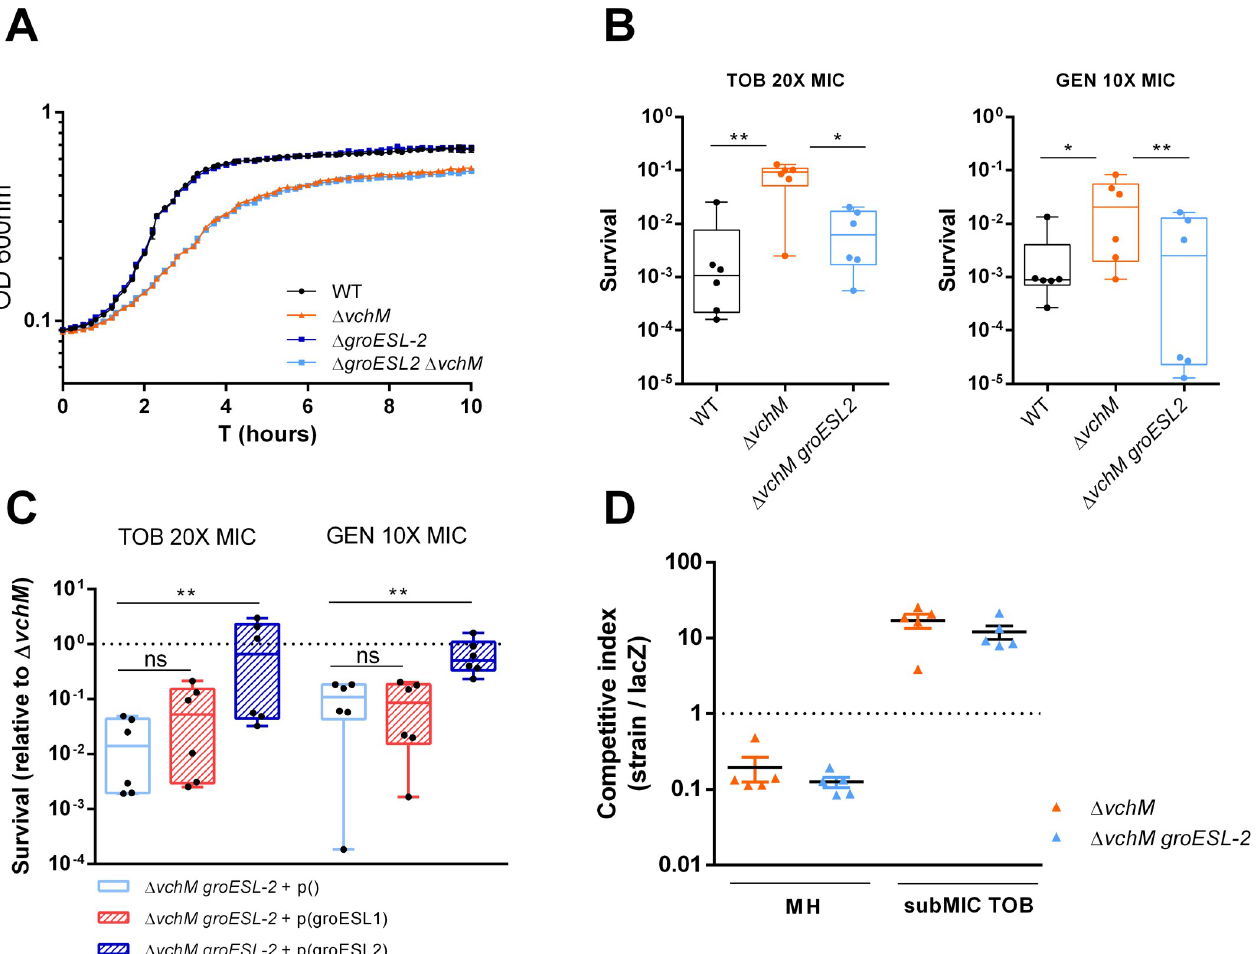
Fig 4. groESL-2 is needed for the increased tolerance of Δ vchM to lethal AG treatment. A. Growth curves in MH medium. Means and SD are represented, n = 3. B. Survival of stationary-phase WT, Δ vchM and Δ vchM Δ groESL-2 cells exposed to lethal aminoglycoside treatment for 7 hours. Box plots indicate the median and the 25 th and 75 th percentiles; whiskers indicate the min and max values (n = 6 from two independent experiments). C. Survival (after 7 hours AG treatment) of Δ vchM groESL-2 double mutant harboring an empty plasmid or a plasmid expressing either groESL-1 or groESL-2 , relative to survival of the Δ vchM with the control plasmid. Box plots indicate the median and the 25 th and 75 th percentiles; whiskers indicate the min and max values (n = 6 from two independent experiments). In B and C statistically significant differences were determined using Friedman’s test with Dunn’s post-hoc test for multiple comparisons. � P < 0.05, �� P < 0.01, ns = not significant. D. In vitro competitions of Δ vchM and Δ vchM groESL-2 double mutant strains against isogenic Δ lacZ reference strain in absence or presence of subMIC TOB, 0.6 μ g/ml; Error bars indicate SD (n =